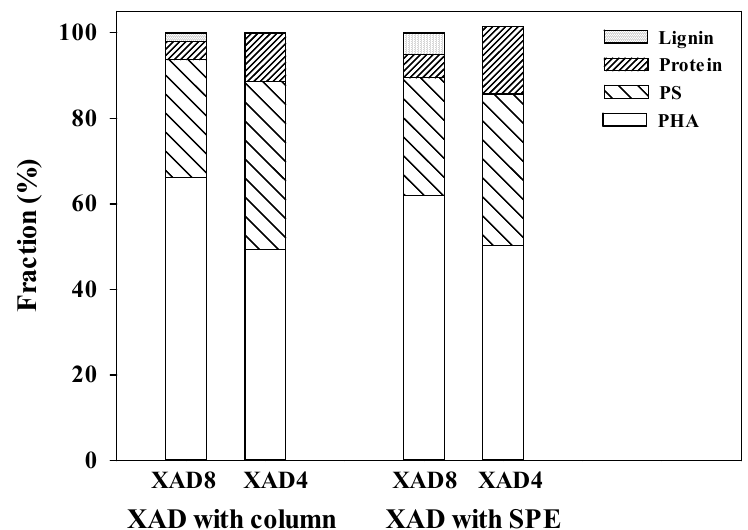
Figure 5. Biopolymer composition of dissolved organic matter (DOM) adsorbed onto XAD 8 and XAD 4 with columns and with SPE devices. (PHA: polyhydroxy aromatic, PS: Polysaccharides).